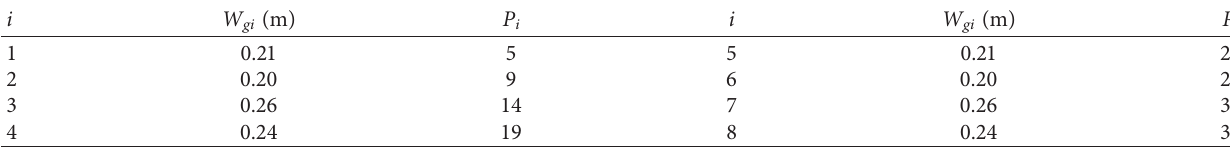
Table 7: Series of widths and locations of potholes I.